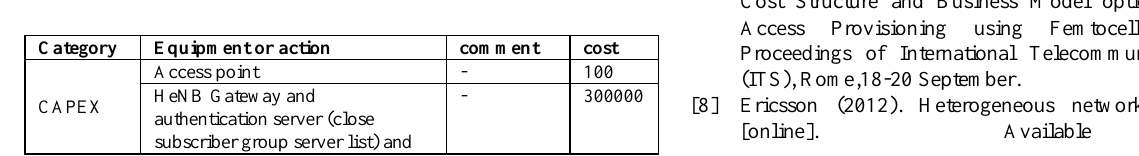
Table A.4: Cost Classification – CAPEX, IMPEX,